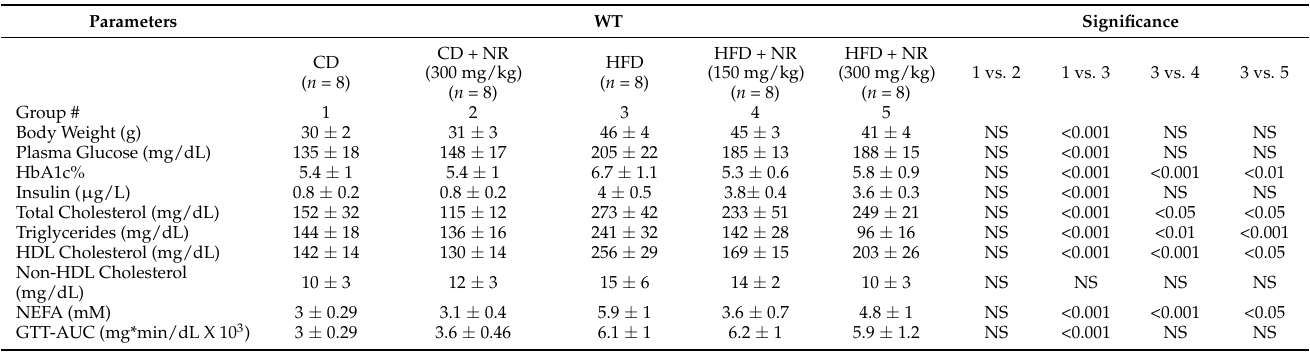
Table 3. Metabolic End Points After 2 Months in WT mice Fed With CD, CD + NR (300 mg/kg), HFD, HFD + NR (150 and 300 mg/kg). NS = Not